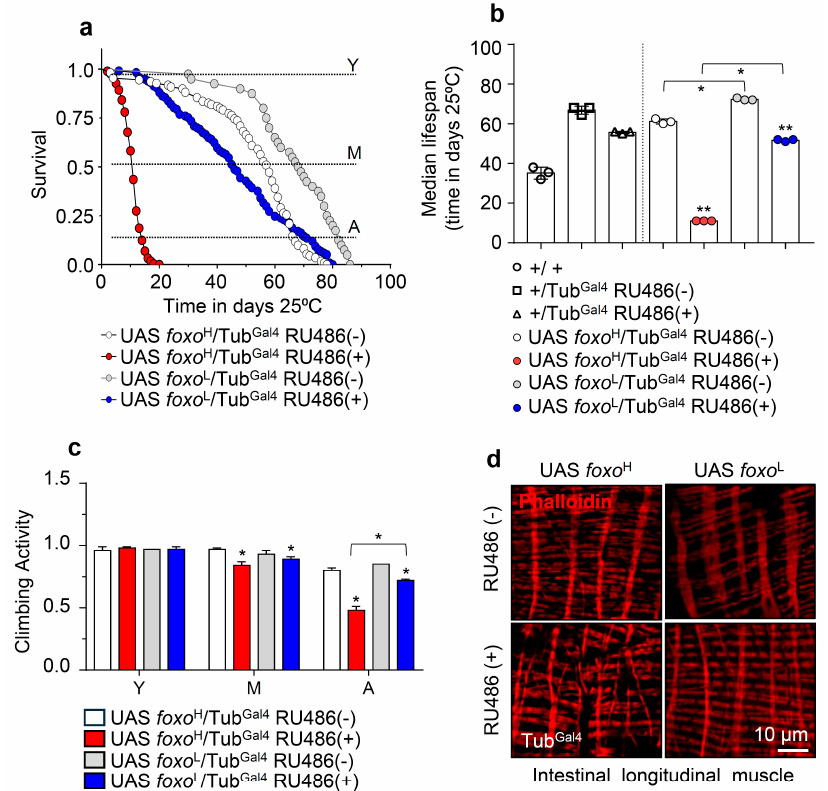
Figure 1. Ubiquitous foxo OE accelerates aging phenotypes in a dose-dependent manner. ( a ) Survival curves of foxo H and foxo L overexpressing flies and ( b ) median lifespan of foxo overexpressing flies vs. respective controls [i.e., +/+ (w 1118 flies), +/Tub Gal4 RU486( − ) and + /Tub Gal4 RU486(+) flies]. Statistics of longevity assays are shown in Table S1. ( c ) Locomotion (climbing activity) of young (Y), middle-aged (M), and aged (A) foxo overexpressing flies vs. controls. ( d ) Representative CLSM images of intestinal longitudinal muscle fibers’ actin filaments (Phalloidin stain) of female middle-aged foxo overexpressing flies vs. control. Bars, ±SD; n ≥ 3, ≥ 10 flies were analyzed per experimental repeat. Statistical significance was measured with unpaired t -test, * p < 0.05, ** p < 0.01. Moreover, we found that both the foxo H and foxo L transgenic lines exhibited a sig-